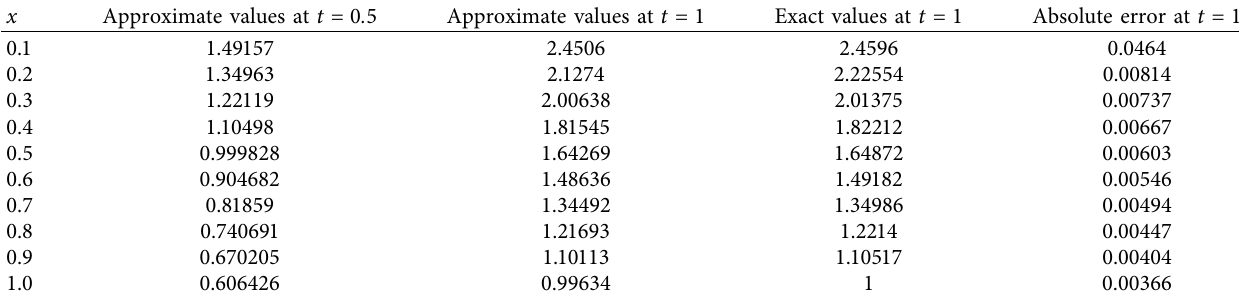
Table 1: Absolute error among the approximate and exact solution at t � 0 . 5 and 1.